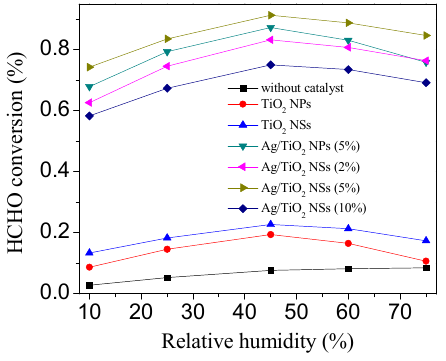
Figure 11. Effect of relative humidity on the removal efficiency of HCHO by different catalysts under visible light irradiation for 240 min.